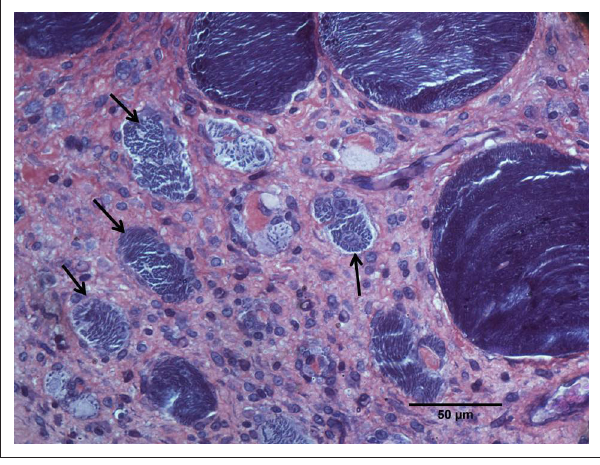
Note: Rounded injured myofibres at the periphery of the cellular area. FIGURE 4: Phosphotungstic acid haematoxylin-stained section from biopsy showing small regenerating myofibres in a cellular matrix.